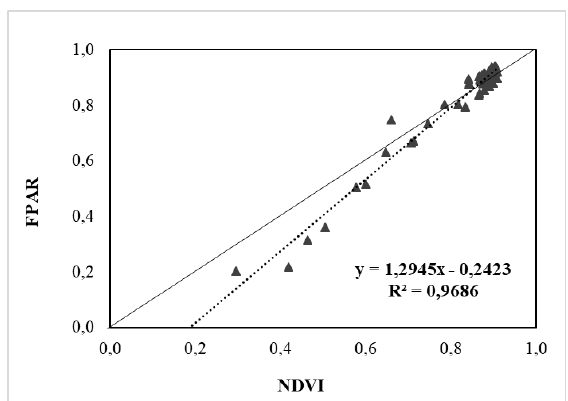
Figure 3. Linear regression between the Photosynthetically Active Absorption Radiation Fraction (FPAR) and the Surface Normalized Difference Vegetation Index (NDVI).